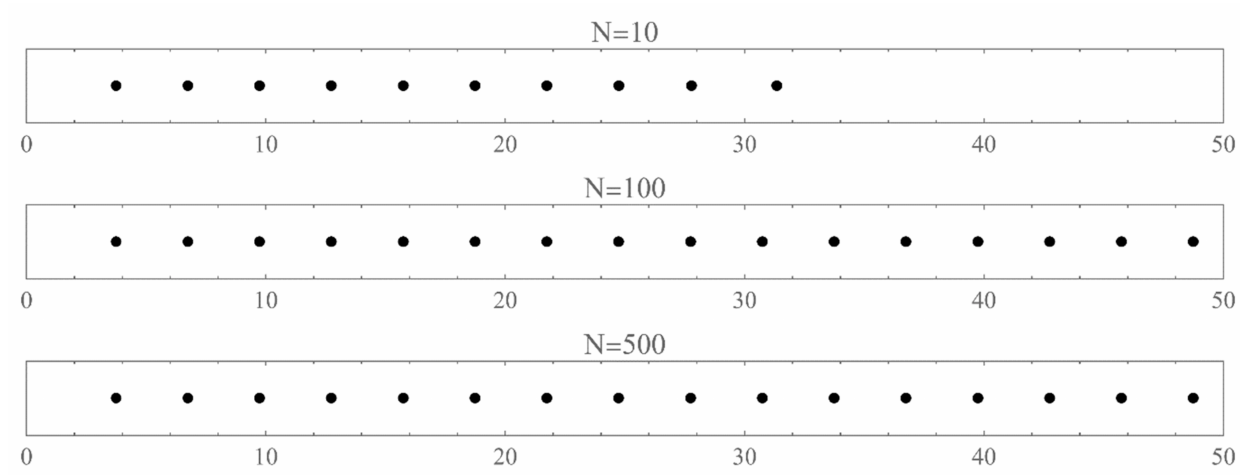
Figure A15. The zeros of P N ( E ) in units of λ 2 for different values of N . We took ω = 3/2, µ = 5/4, and θ = π . The energies are found to converge to a discrete equally spaced spectrum.